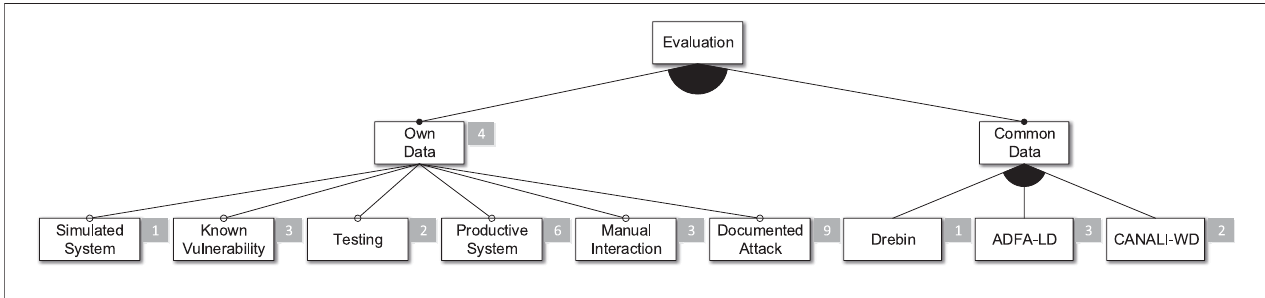
FIGURE 10 | The evaluation